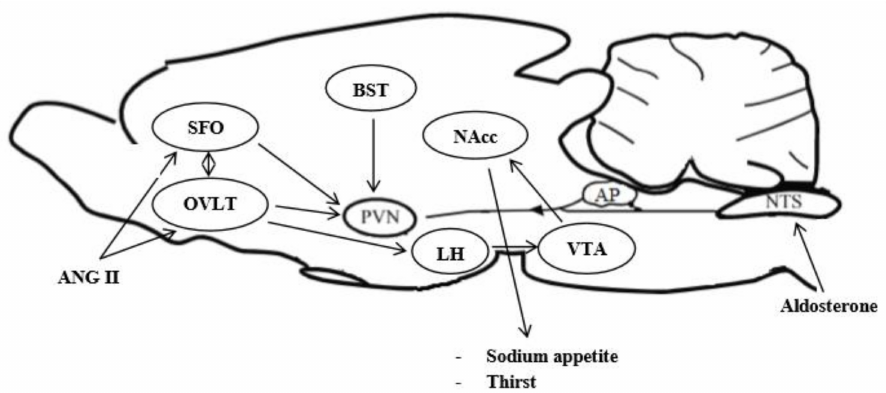
Figure 2. Midsaggital section of rat brain showing neural circuit for aldosterone and angiotensin II-induced sodium appetite. ANG II: angiotensin II—SFO: subfornical organ—OVLT: organum vasculosum lamina terminalis—PVN: paraventricular nucleus—AP: area postrema—NTS: nucleus of the solitary tract—LH: lateral hypothalamus—VTA: ventral tegmental area—NAcc: nucleus accumbens septi—BST: bed nucleus of the stria terminalis. BST express GABAergic inputs, VTA DAergic and PVN OTergic. ANG II acts via AT 1R in OVLT and SFO, while aldosterone via HSD2 neurons of